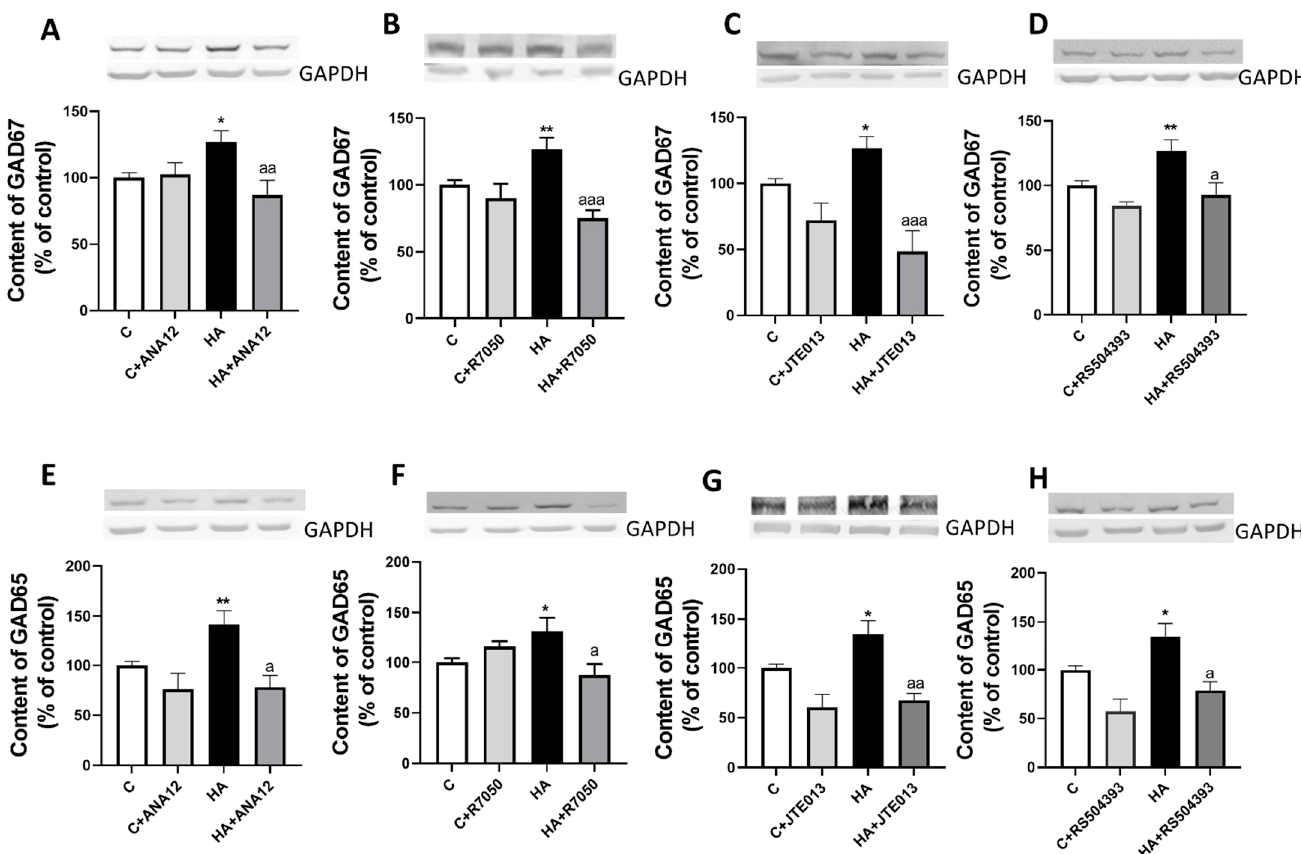
Figure 2. Hyperammonemia increases the content of GAD67 ( A – D ) and GAD65 ( E – H ) in cerebellar slices. Ex vivo treatment with ANA12, R7050, JTE-013, or RS504393 reverses these increases. Western blot was performed as indicated in Section 4. Values are the mean ± SEM of 19–24 rats per group. Values significantly different from control rats are indicated with asterisks, and from hyperammonemic rats are indicated with “a”. * p < 0.05; ** p < 0.01; a p < 0.05, aa p < 0.01; aaa p < 0.001. ( A – H ) F values were 4.450, 7.968, 9.863, 5.499, 6.864, 3.683, 7.582, and 7.051, respectively. Data were